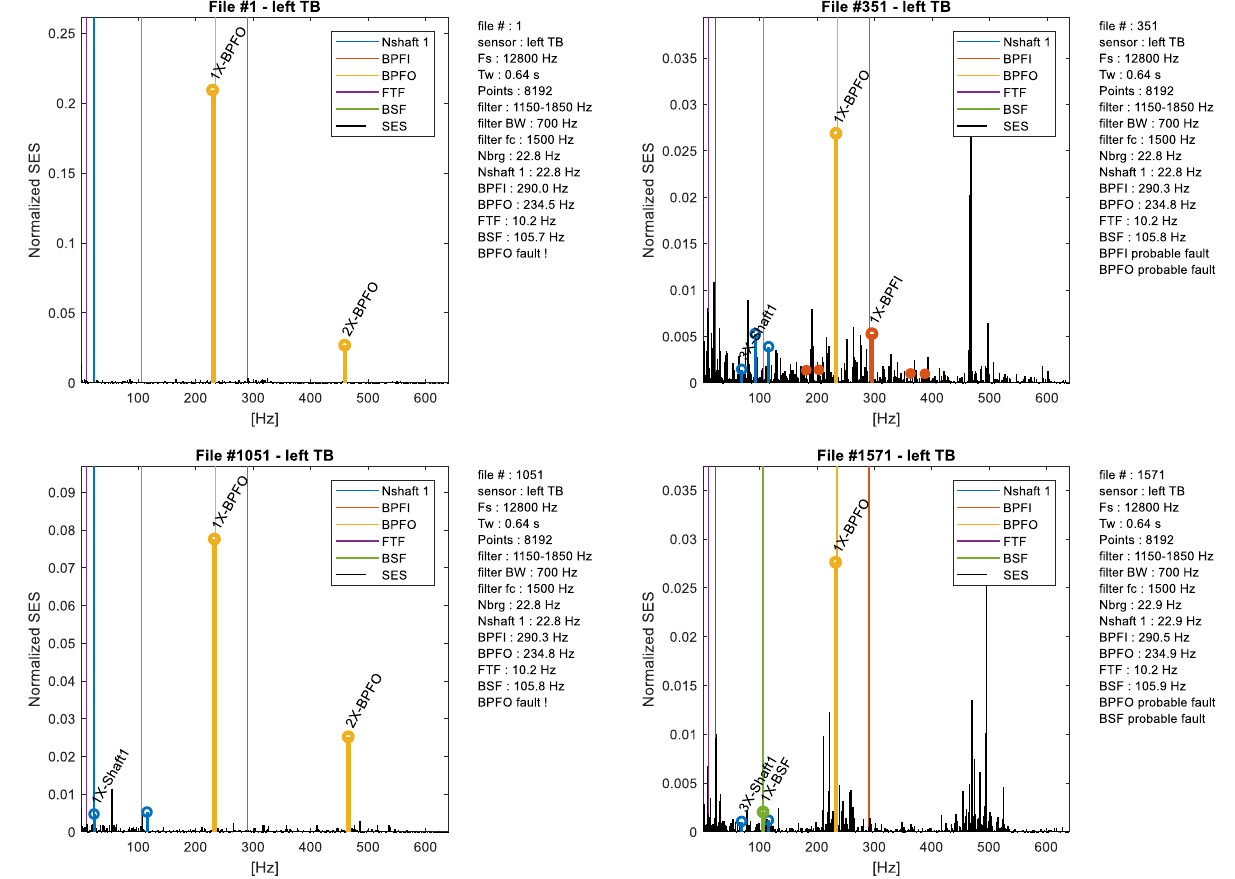
Figure 9. Values of the normalized SES for some data records—left TB.